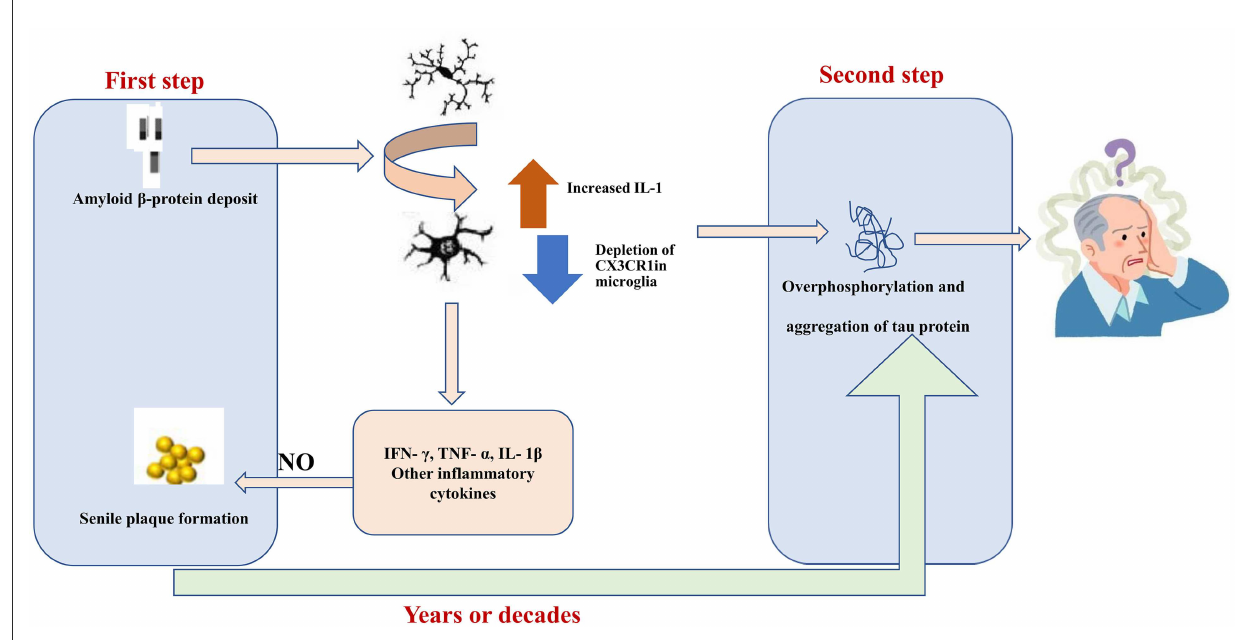
FIGURE2 A β 1-42 activates MG through CD36 and the toll-like receptor TLR2-TLR6 heterodimer. Subsequently, the expression levels of pro-inflammatory factors, interleukin (IL)-1 β , and tumor necrosis factor (TNF)- α were significantly increased. In which nitric oxide produced by activated MG can lead to nitration of A β peptide 10Y, and this modification promotes the formation of senile plaques. Elevated IL-1 levels in MG caused by depletion of CX3C chemokine receptor 1 (CX3CR1) lead to hyperphosphorylation of tau. Hyperphosphorylated tau aggregates are formed in the nerves and eventually lead to neuronal cell death. The gap between these two waves of destruction could be years or even